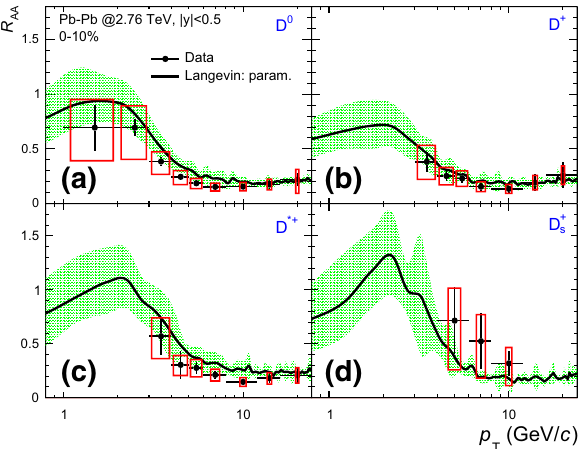
Fig. 3 Comparison between experimental data (red box [39,40]) and LGR Model-B calculations (solid black curve with green uncertainty band) for the nuclear modification factor R AA , of a D 0 , b D + , c D ∗+ and d D + s at mid-rapidity ( | y | < 0 . 5) in the (0–10%) centrality Pb–Pb √ s NN = 2 . 76 TeV collisions at